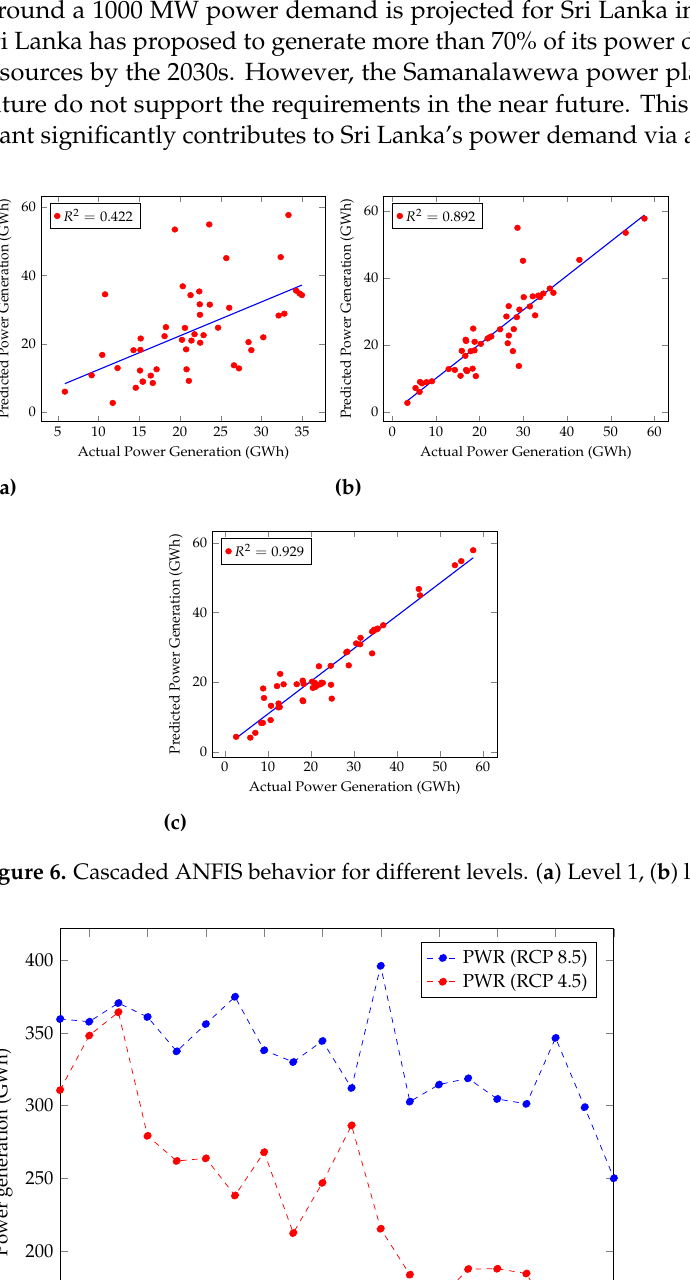
Figure 8. Power generation prediction from year 2021 to 2040 Figure 7. Power generation predictions from year 2021 to